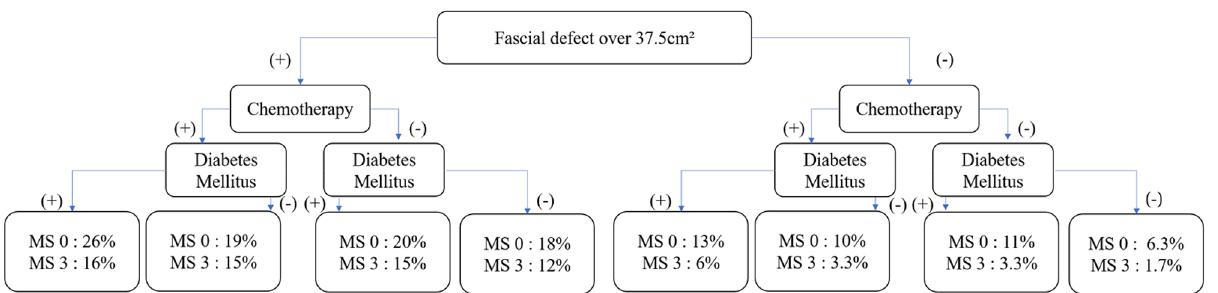
Figure 5. Different probabilities of abdominal complications after autologous breast reconstruction with muscle sparing TRAM flap. The maximal risk with every risk factor present was calculated as 26%, and minimal risk in none of risk factors present was